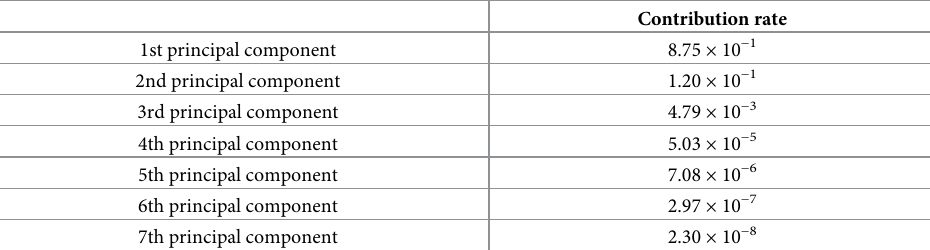
Table 5. Contribution rate of each principal